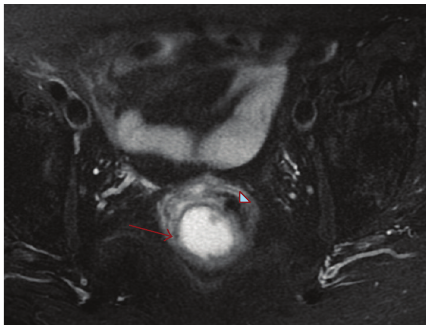
Figure 3: EUS. Subepithelial mass of 3 cm diameter with perirectal